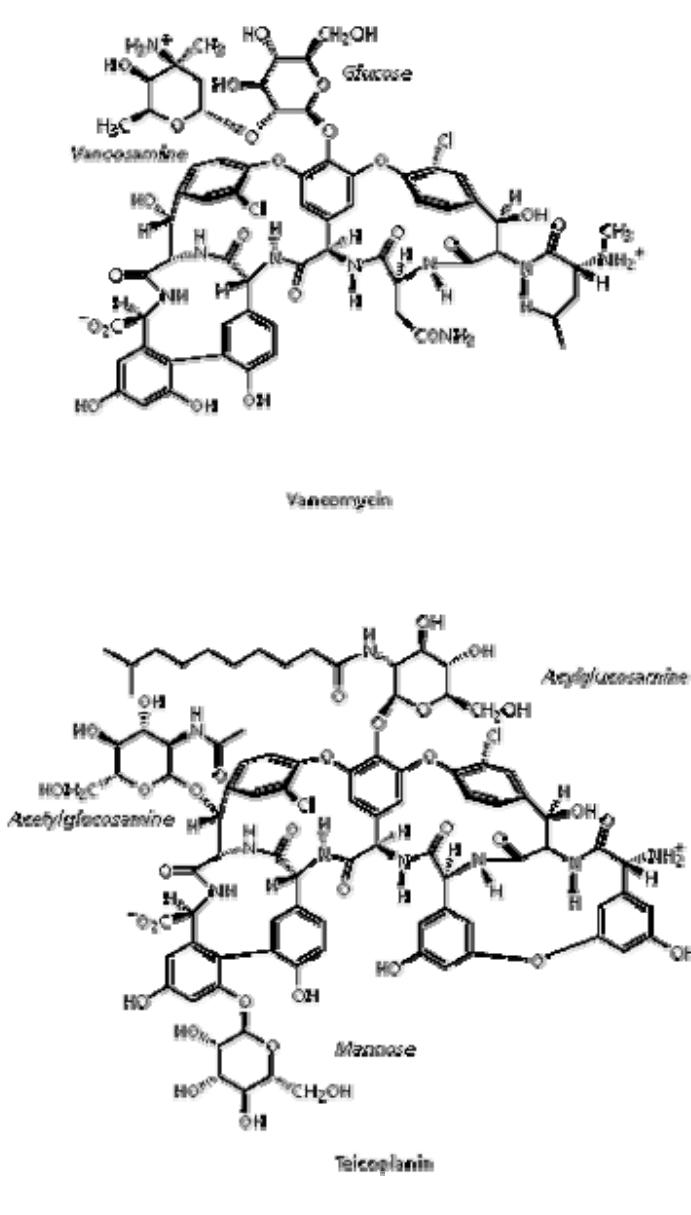
Figure 1. Structures of the glycopeptide antibiotics, vancomycin and teicoplanin (From Gilpin & Milner,